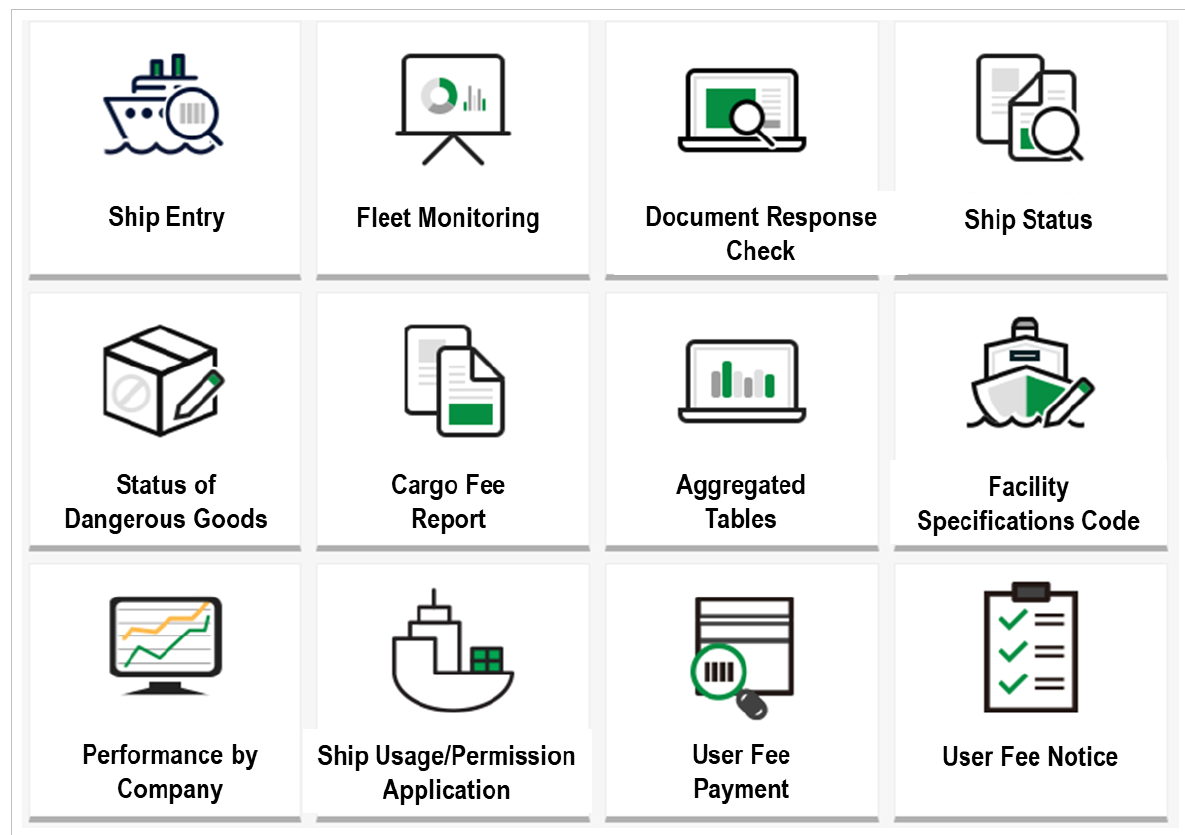
Figure 2. Port-MIS (Port Management Information System) web-based service platform [40] .